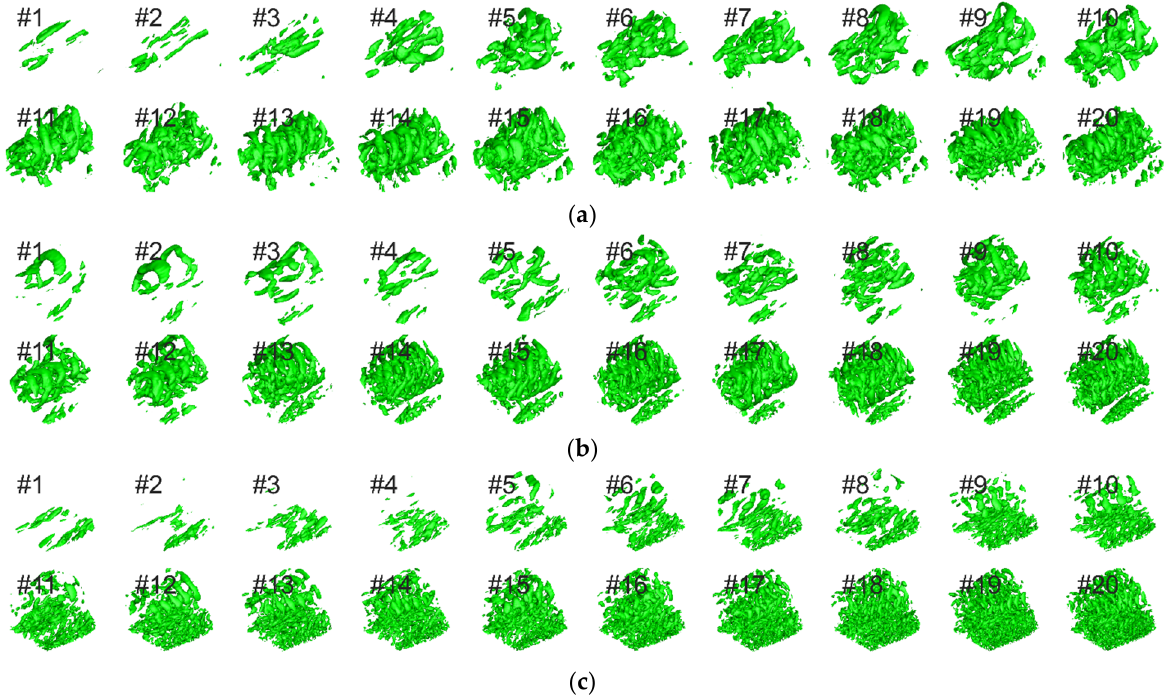
Figure 14. Vortical structures of the first 20 modes in the SWBLI region with ( a ) Ma = 1.5, ( b ) Ma = 2.0, ( c ) Ma = 2.5.